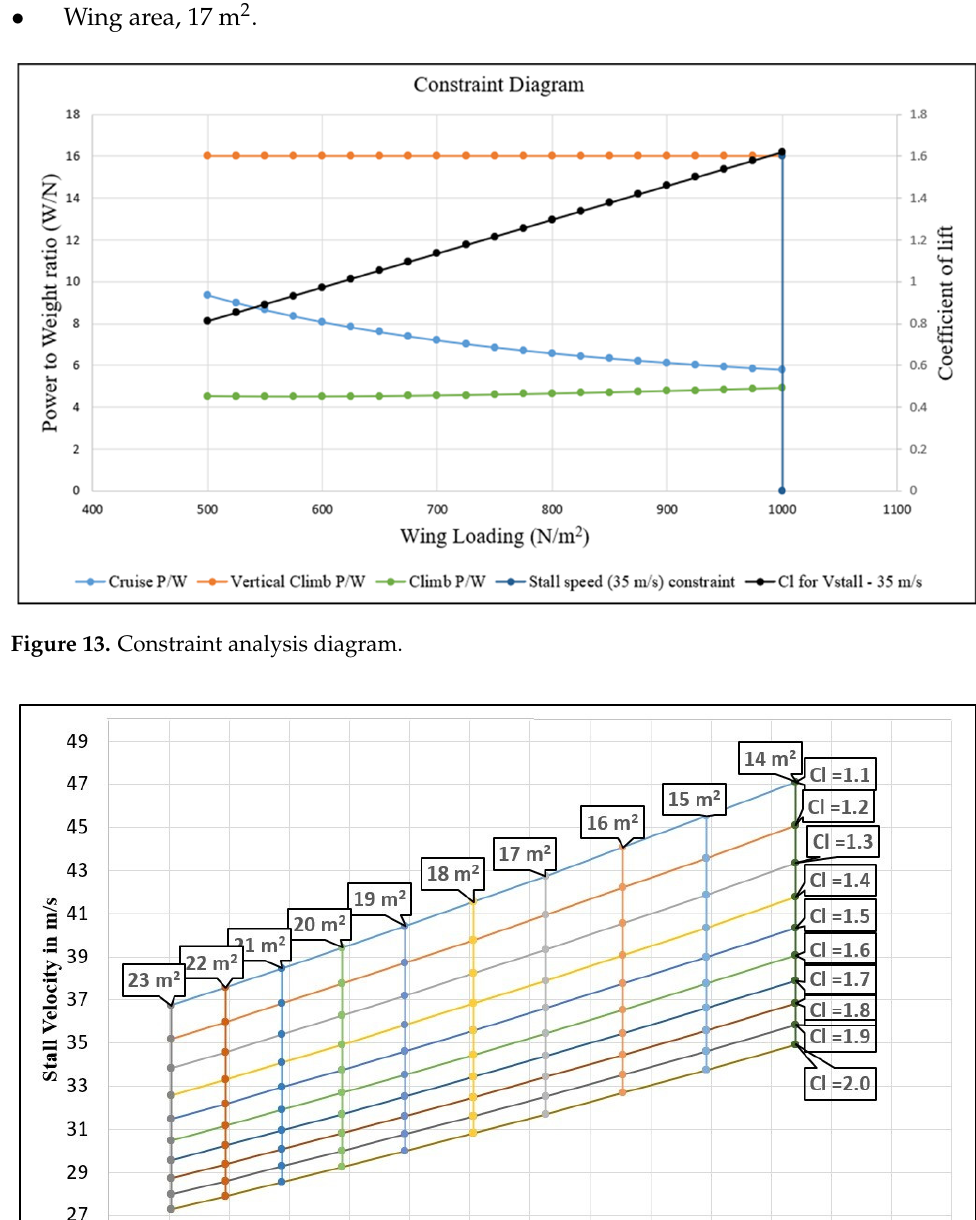
Figure 13. Constraint analysis diagram.